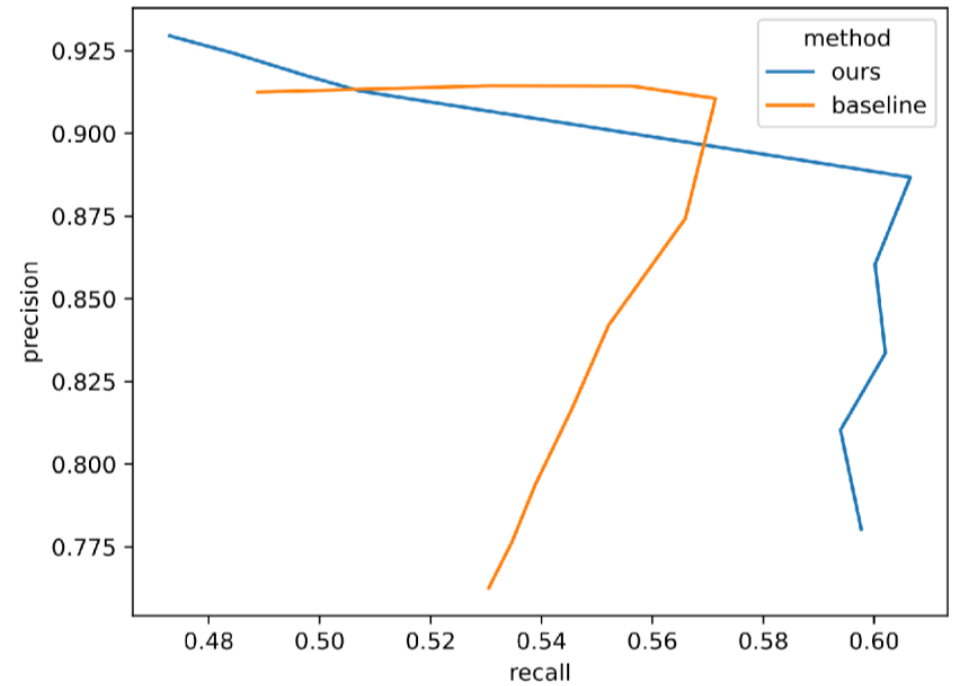
Figure 13. The PR curve comparison.